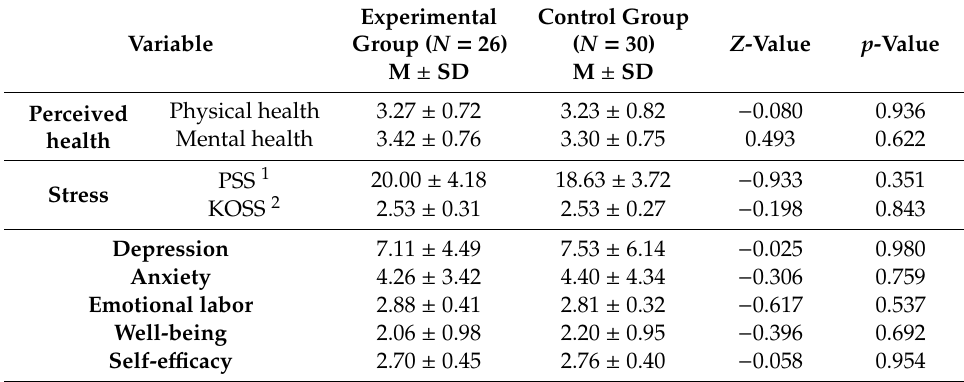
Table 2. The homogeneity of the measured variable ( N =